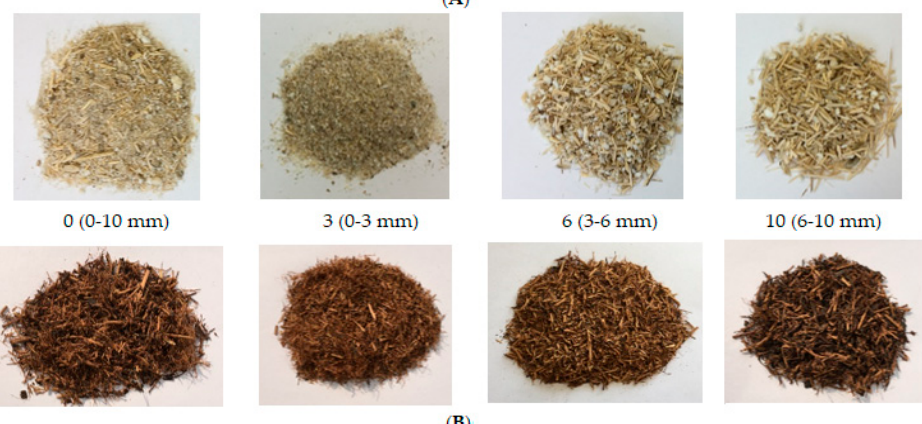
Figure 2. ( A ) Ground sunflower stalks. ( B ) Ground hazelnut husks of different size distributions.